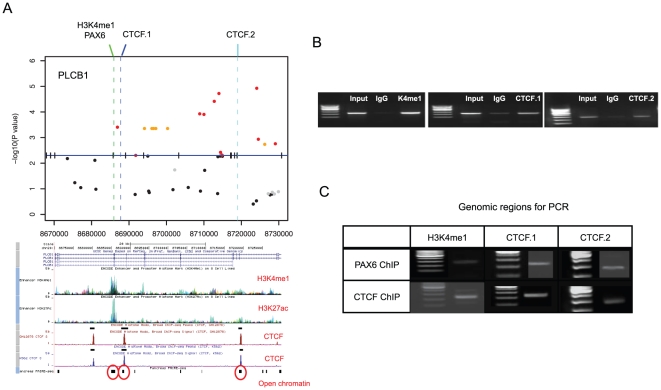
Zoomed-in P value plot and chromatin signatures for the PLCB1 region.(A) The dotted lines indicate the DNA regions selected for H3K4me1, PAX6, and CTCF ChIP PCR. Below is the UCSC Genome Browser screen showing H3K4me1, H3K27ac, and CTCF. Corresponding open chromatin [34] is shown. (B) The results of ChIP PCR for H3K4me1, PAX6, and CTCF. Input DNA and IgG were used as control. (C) Cross ChIP PCR between PAX6 and CTCF. PAX6 ChIP DNA was detected in the two CTCF sites, and CTCF ChIP DNA was detected in the PAX6 site.